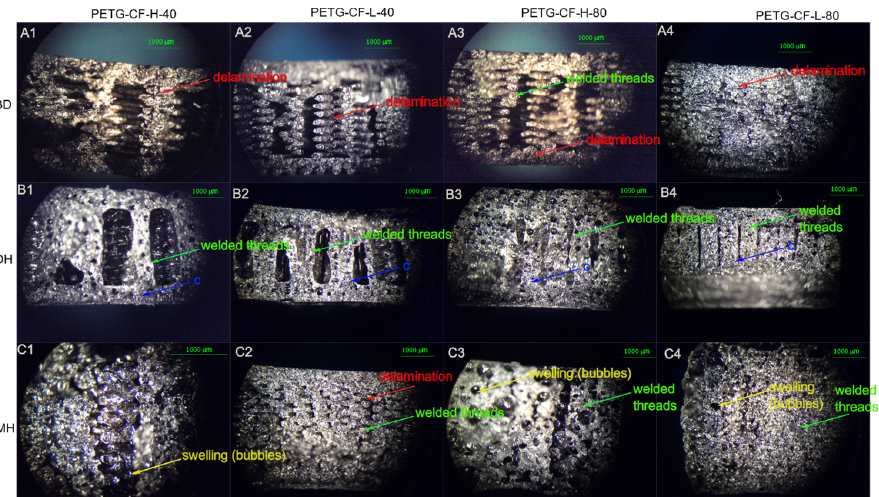
Figure 10. Optical microscope images of the fracture surface of the 3D printed PETG ‐ CF ‐ based samples after Charpy test. Control samples (without sterilization process treatment): ( A1 – A4 ) PETG ‐ H ‐ 40, PETG ‐ L ‐ 40, PETG ‐ H ‐ 80 and PETG ‐ L ‐ 80; samples after the Dry Heat (DH) sterilization process: ( B1 – B4 ) PETG ‐ H ‐ 40, PETG ‐ L ‐ 40, PETG ‐ H ‐ 80 and PETG ‐ L ‐ 80; as well as samples after the Moist Heat (MH) sterilization process: ( C1 – C4 ) PETG ‐ H ‐ 40, PETG ‐ L ‐ 40, PETG ‐ H ‐ 80 and PETG ‐ L ‐ 80.